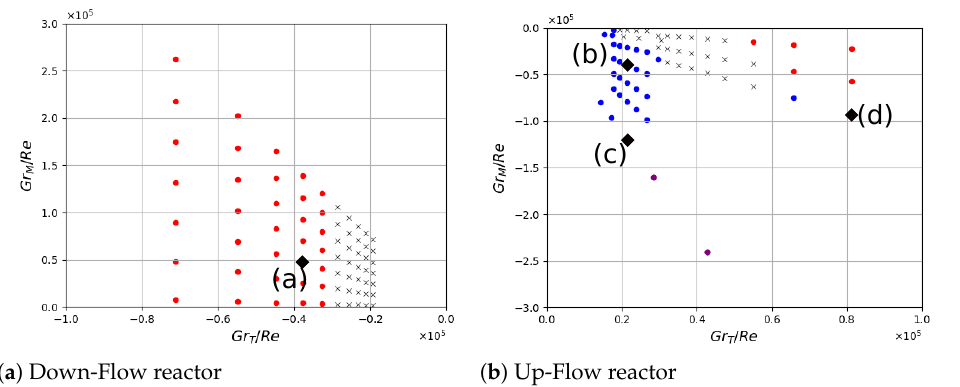
Figure 8. Instabilities in terms of thermal and molar Grashof numbers over the Reynolds number. Black cross I ( Ω HVPE ) = 0. Red dots: I ( Ω Out ) > 0. Blue dots: I ( Ω In ) > 0. Violet dots: I ( Ω In ) × I ( Ω Out ) > 0. Markings (a)–(d) refer to Figure